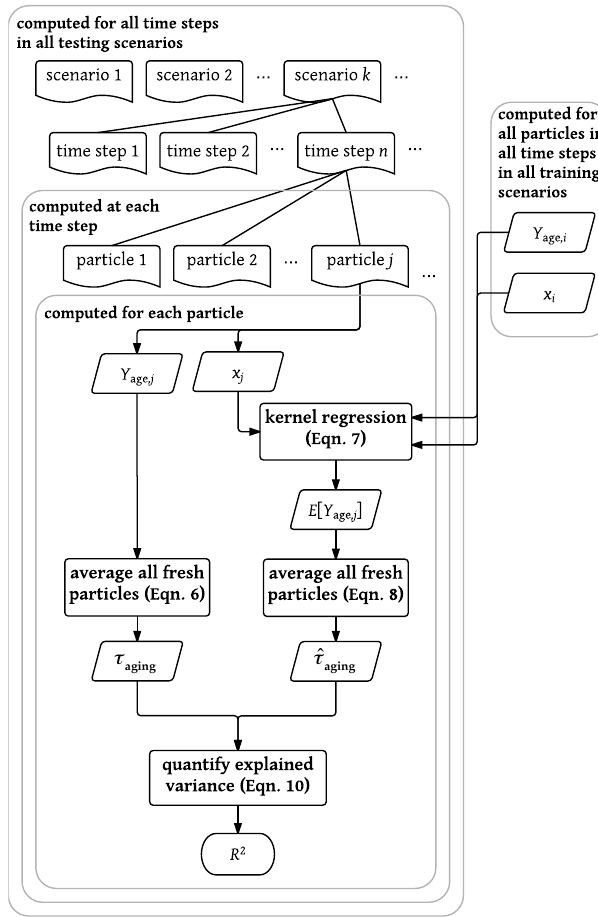
Figure 6. Procedure for applying kernel regression to predict black carbon’s aging timescale and quantifying the portion of variance explained by that prediction, shown for a hypothetic input variable x